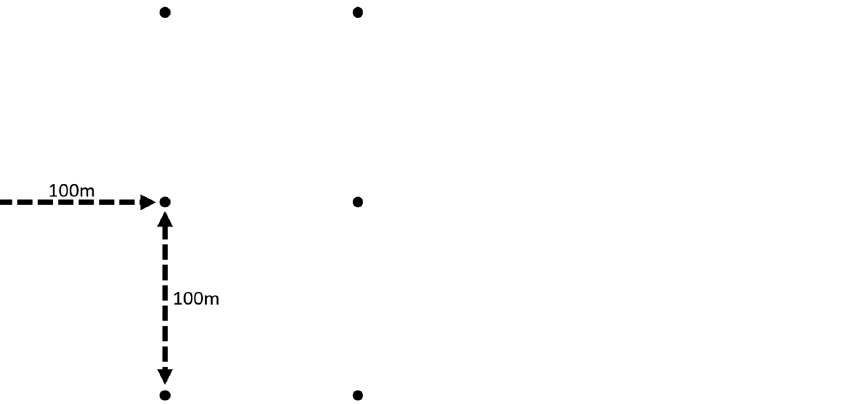
Figure 2. Nine single point scans (represented by the points) were collected in each forest stand placed at 100 m spacing. This was to get adequate representation of each forest type while limiting spatial autocorrelation between